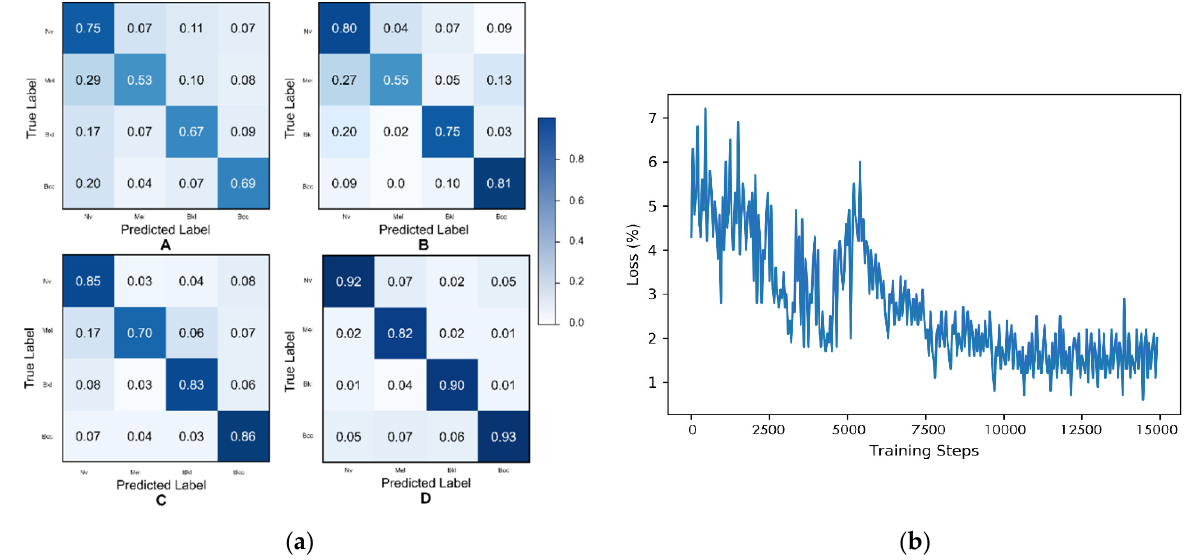
Figure 7. Confusion matrices of various generative models. ( a ) ( A )—Confusion matrix of the CNN classifier when trained only on HAM10000 images without any generative image. ( B )—When classifier training includes the HAM10000 training set and the images generated by GAN [15]. ( C )—When classifier includes HAM10000 training set and the images generated by DeLiGAN. ( D )— When classifier training includes the HAM10000 training set and the images generated by proposed TED-GAN. ( b ) Training loss of the generator of TED-GAN (GAN 2 ).